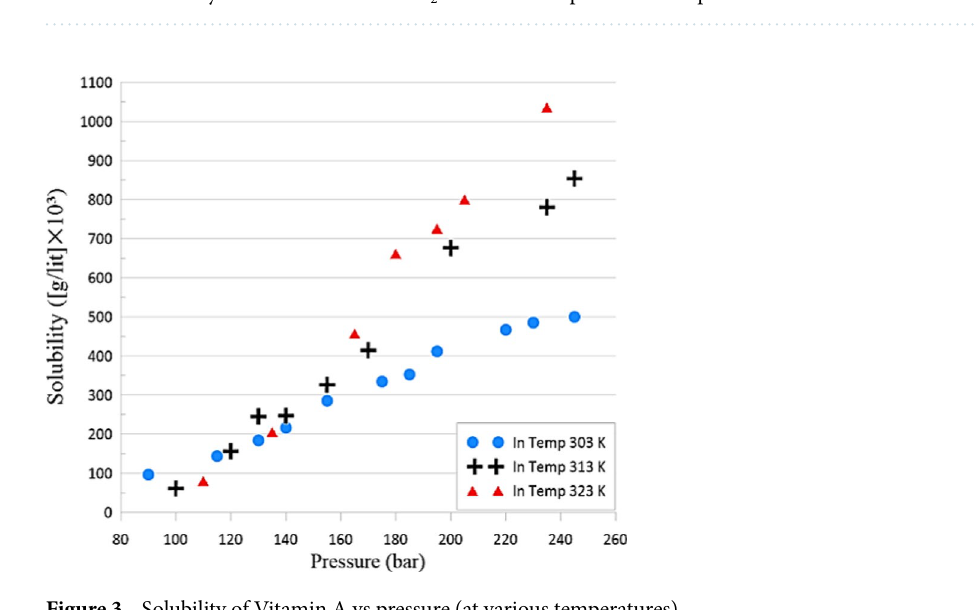
Table 2. Solubility of vitamin A in SC-CO 2 at various temperatures and pressures.